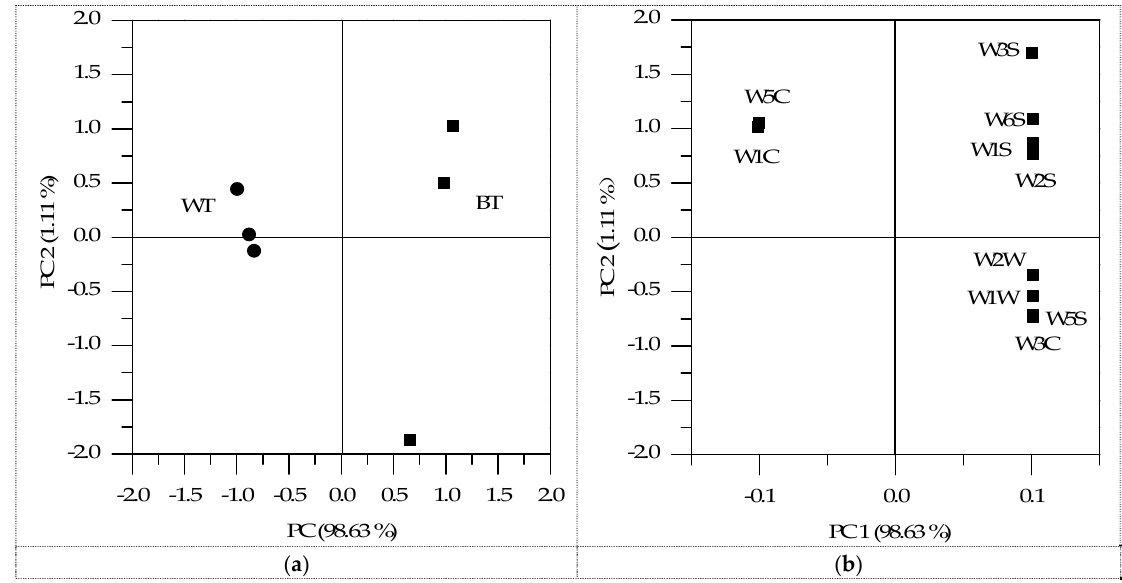
Figure 5 . Principle component analysis (PCA) results of electronic nose analysis: ( a ) BT and WT samples; ( b ) ten sensors (W1C, W5S, W3C, W6S, W5C, W1S, W1W, W2S, W2W and W3S) of electronic nose.